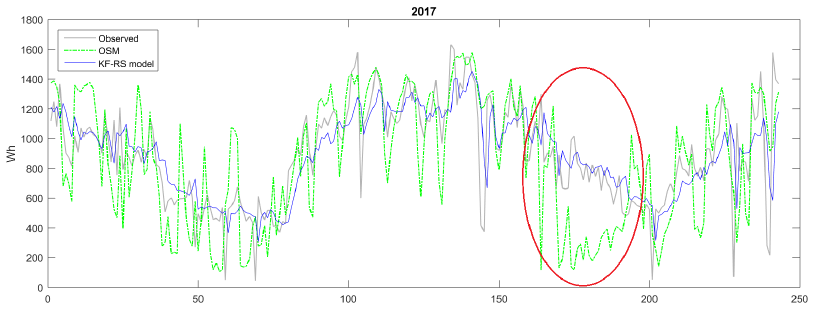
Figure 12. Prediction of the daily energy demand (summary) obtained by optimized simulation model (OSM) and Kalman filter-enhanced reshaped simulation model (KF-RS) for the year 2017.